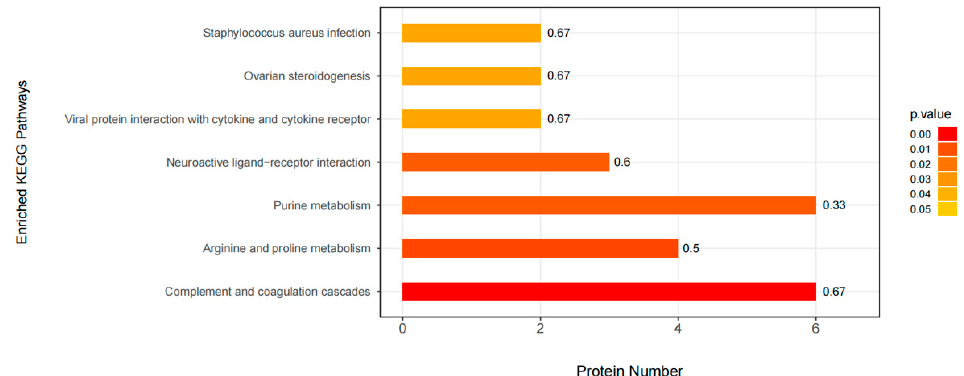
Figure 5. KEGG pathway enrichment analysis. The ordinate represents the significantly enriched KEGG pathway; the Abscissa represents the number of differentially expressed proteins contained in each KEGG pathway; the bar chart color indicates the significance of the enriched KEGG pathway, that is, the p value is calculated based on the Fisher accurate test (Fisher’s Exact Test), and the color gradient represents the p value. The label at the top of the bar chart shows the enrichment factor (richFator <= 1). The enrichment factor indicates the proportion of the number of differentially expressed proteins involved in a KEGG pathway to the number of proteins involved in the pathway among all identified proteins.